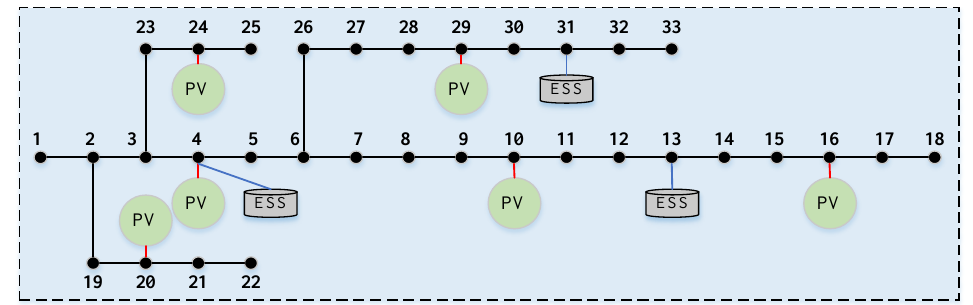
Figure 9. The optimal location results for PV and ESS.